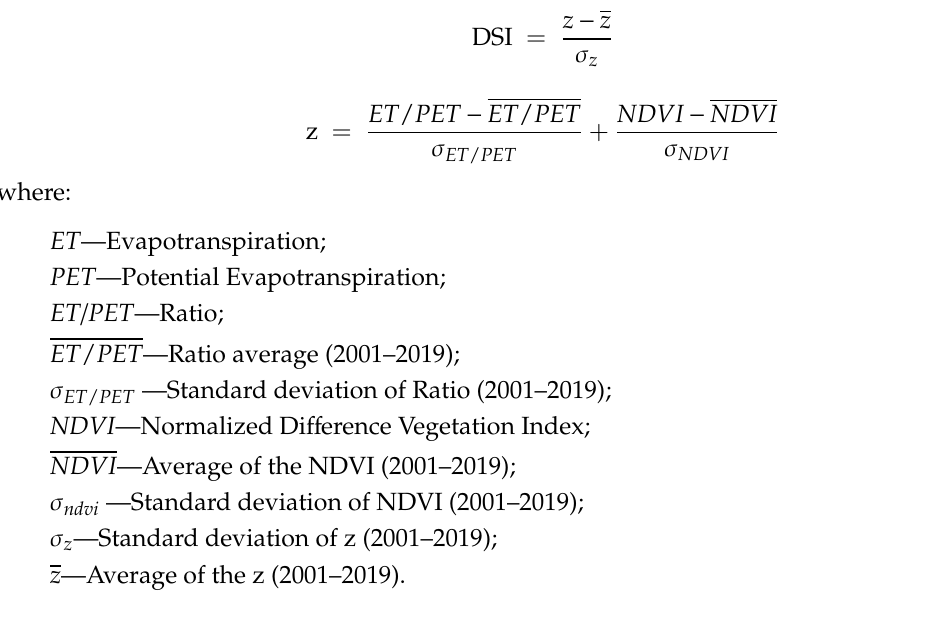
Table 3. Drought intensity according to EDO classification 1